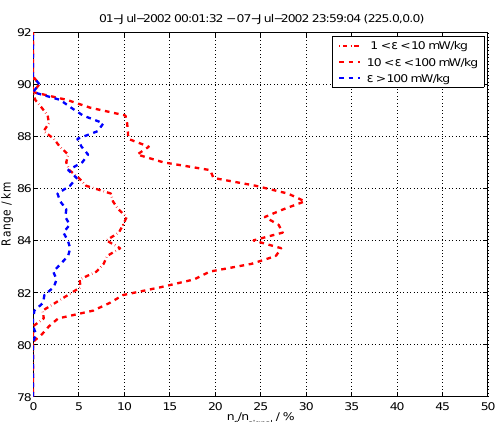
Fig. 12. Height distribution of turbulent energy dissipation rates for the same period shown in Fig. 11. The number of turbulent energy dissipation rates of three groups of dissipation strength n (cid:15) are normalized by the PMSE occurrence larger than